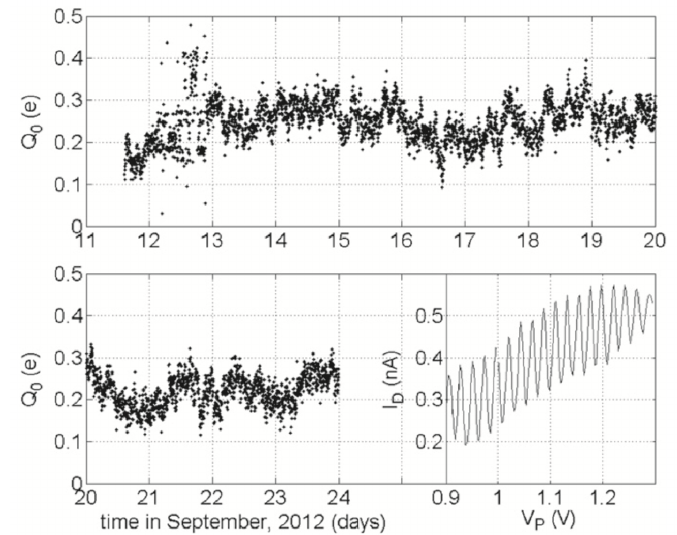
Figure 11. Charge offset drift in the same device as in Figure 10. The size of the drift is ∆ Q 0 ≈ 0.15e, intermediate between all-silicon devices and Al/AlO x devices. The inset shows the Coulomb blockade oscillations which were used to extract the ∆ Q 0 values. Data were obtained at a temperature of 2.2 K. Reproduced with permission from reference [48], Copyright 2014, Institute of